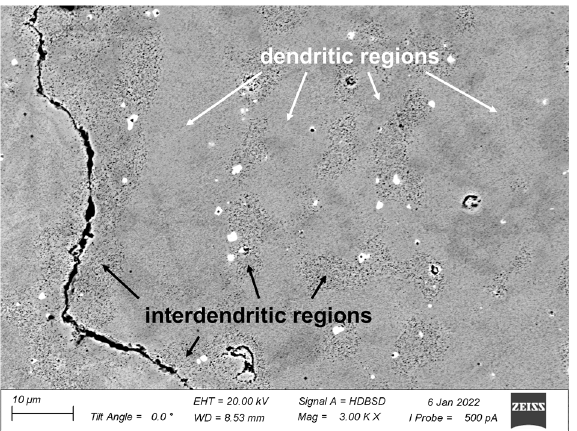
Figure 7. Optical microscope image of specimen S13. The arrow indicates the location that is shown at a higher magnification in Figure 8.